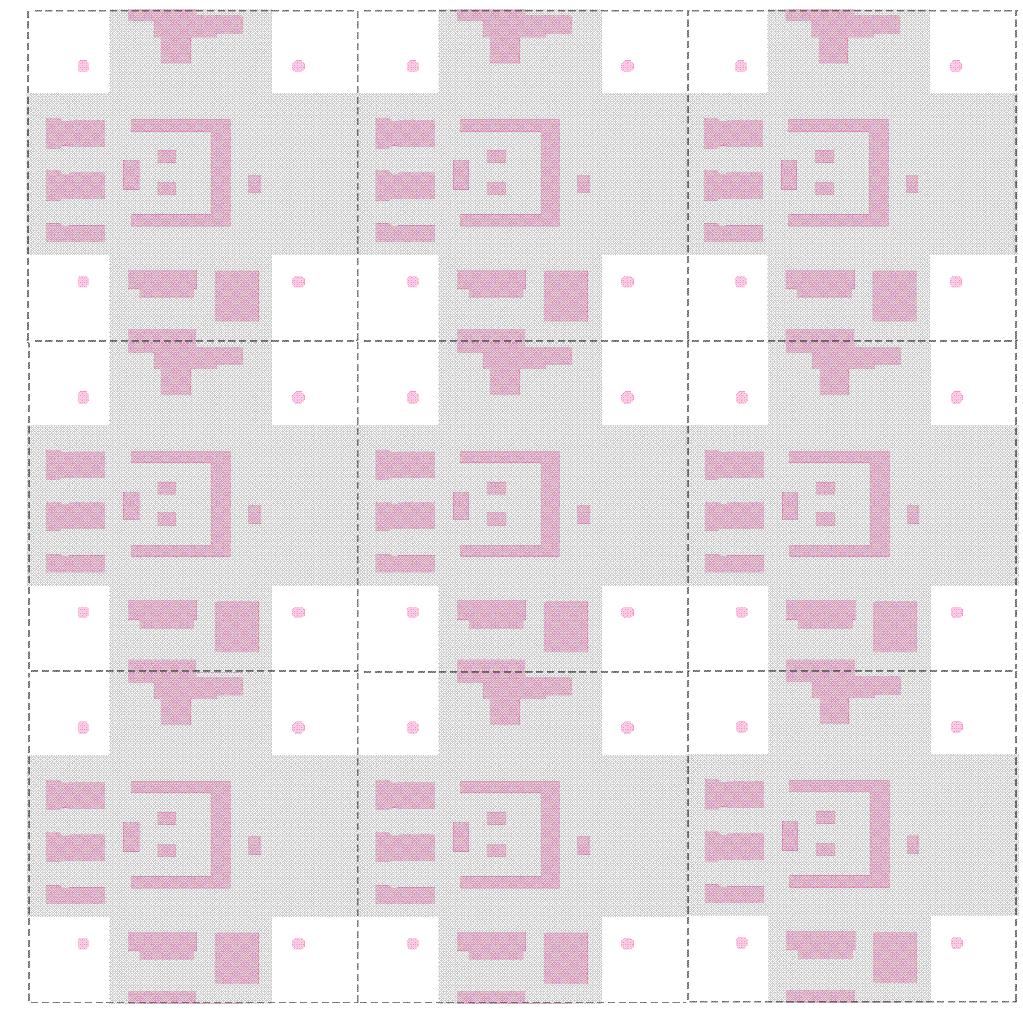
Figure 5. Layout of a 3x3 array of preShape pixel from the TPAC1.0 sensor. Only the N-well (purple) and deep P-well (grey) layers are shown. Every N- well but the detecting diodes have got deep P-well underneath. The non-physical boudary between pixels is shown as a dotted